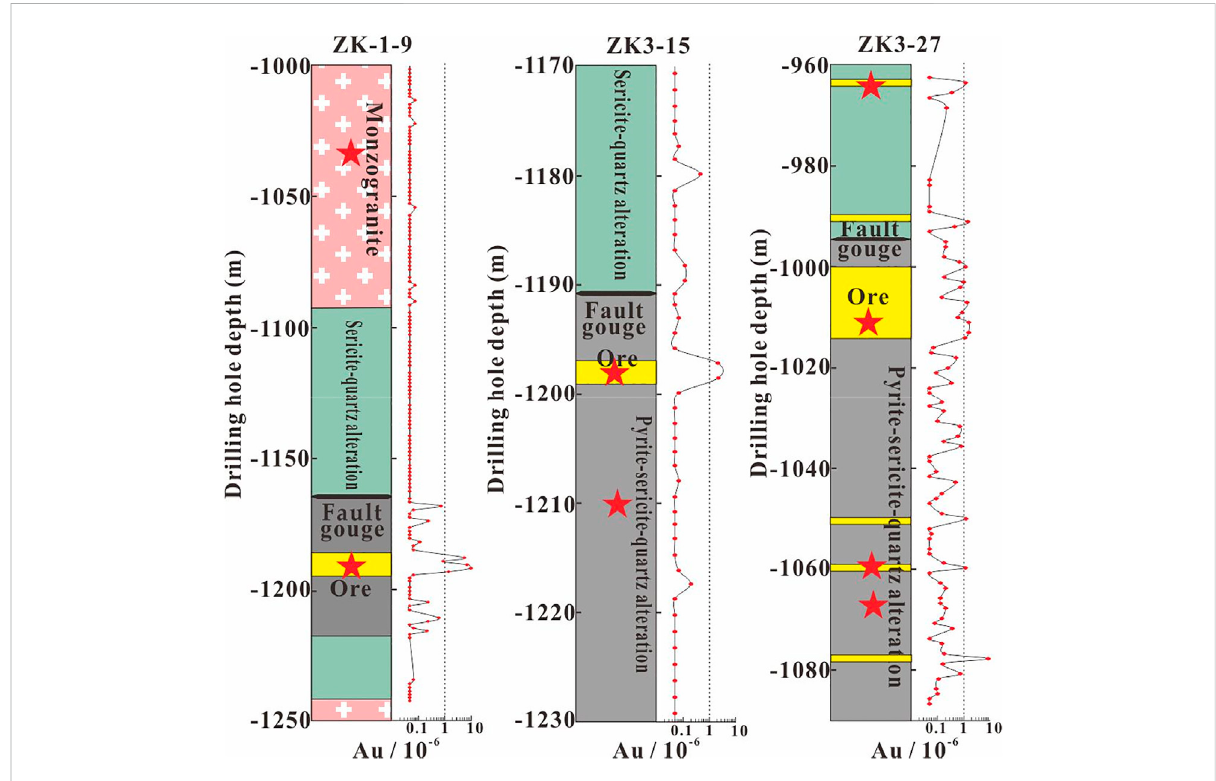
FIGURE 2 Comparison of Au distribution from three typical drilling hole (zk-1-9, zk3-15, and zk3-27) in Jiaodong area (Data from Shandong gold